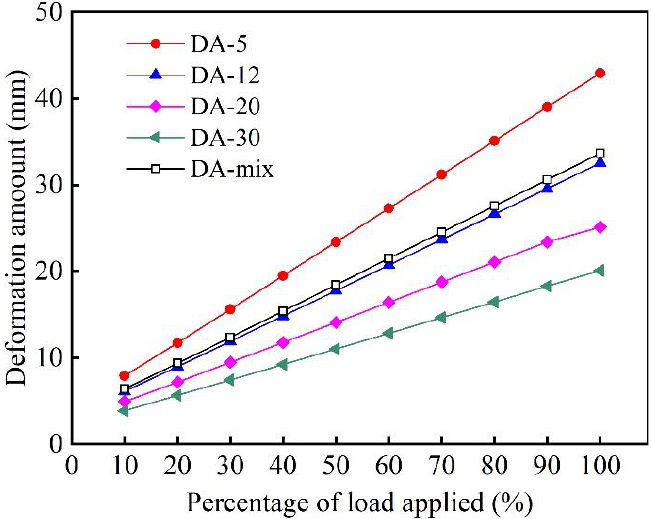
Figure 12. Curve of deformation amount of deformation adjustors variation with percentage of load applied.